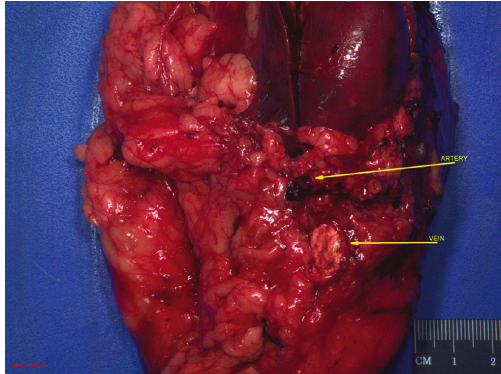
Figure 6: Gross pathology showing coil within the renal artery and tumor thrombus in the main renal